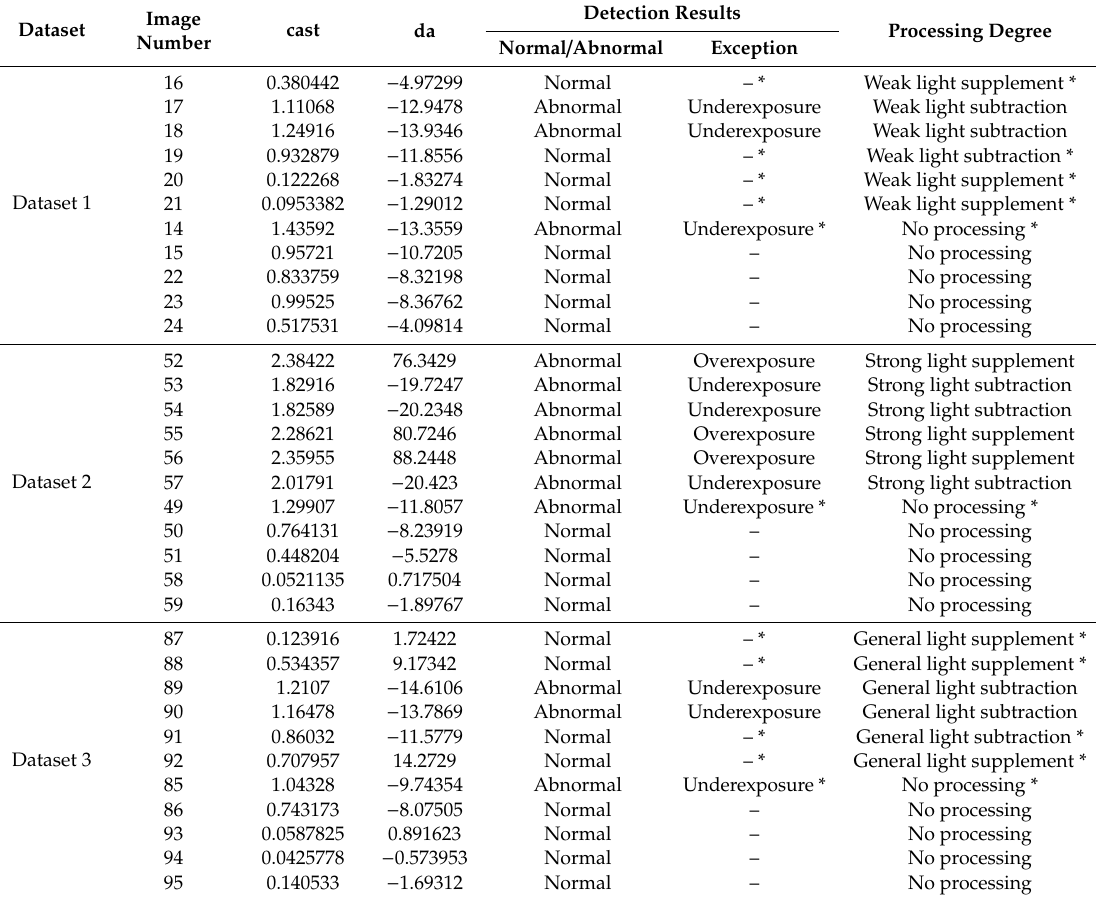
Table 3. Cast / da brightness detection results based on local grayscale mean